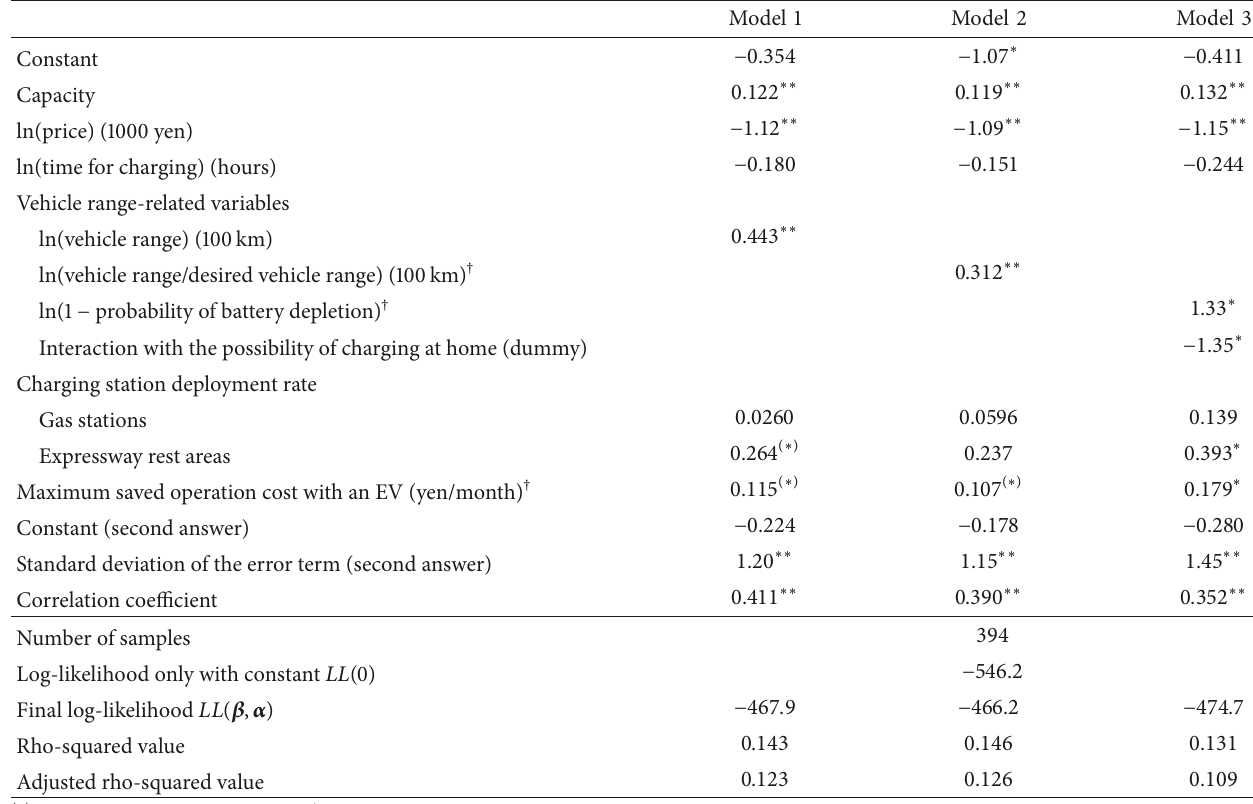
Table 3: Estimation results of the three EV purchase